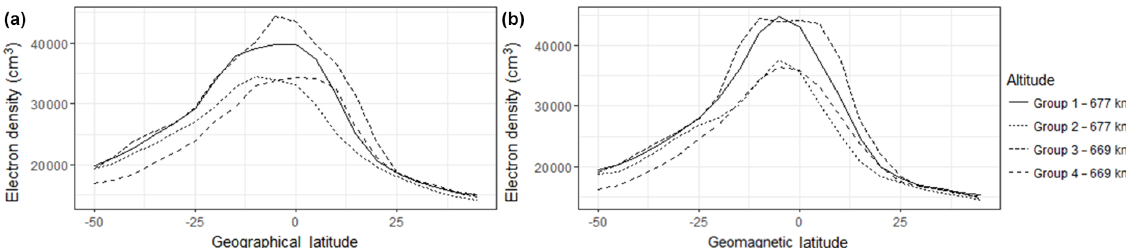
Figure 7. Variation in the average descending electron density with